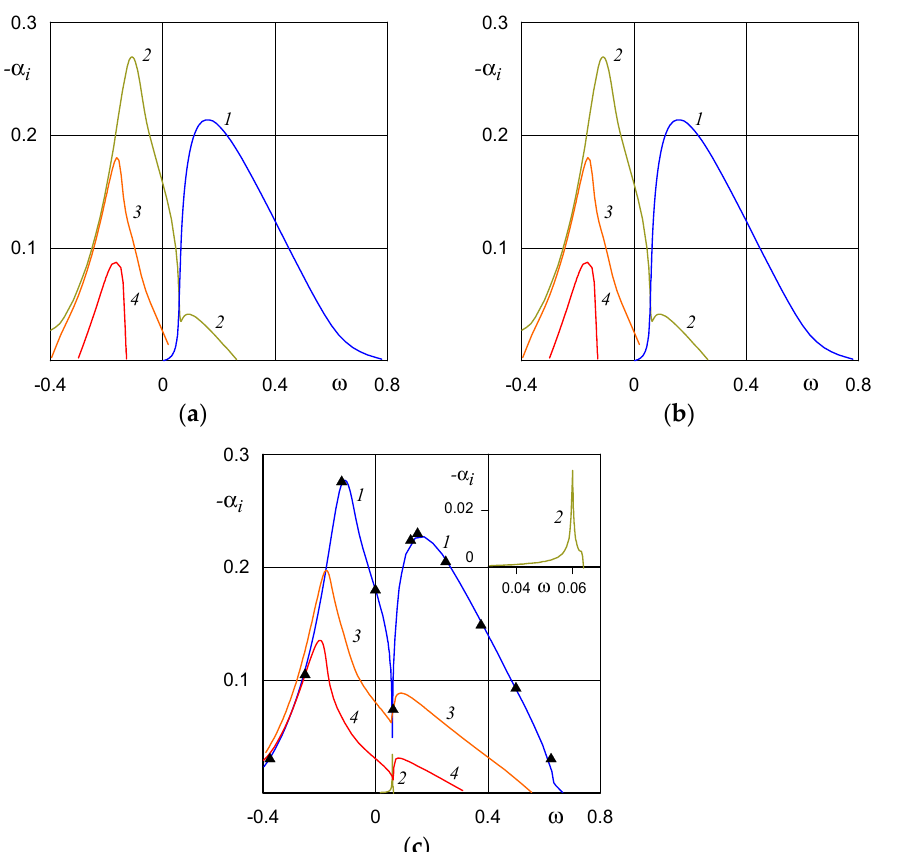
Figure 8. The growth rate from the oscillation frequency (spatial instability) for modes 1–4 (curves 1–4) for q = 0.7 ( a ) Re = 1000; ( b ) Re = 5000; ( c ) Re = 10,000. The triangular symbols correspond to the inviscid theory. The presence of two local maxima in the depicted relations for modes 1, 3 and 4 is associated with the branch point for ≈ω 0.06.